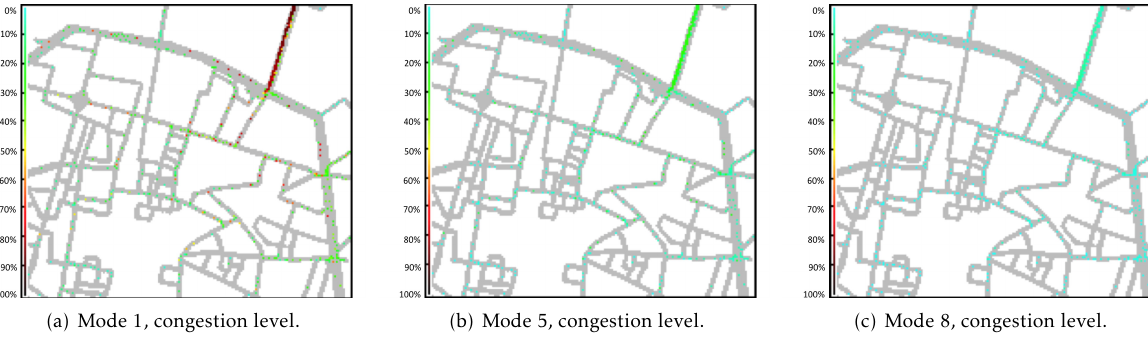
Figure 6. Beacon delivery rate as a function of the position of receiving